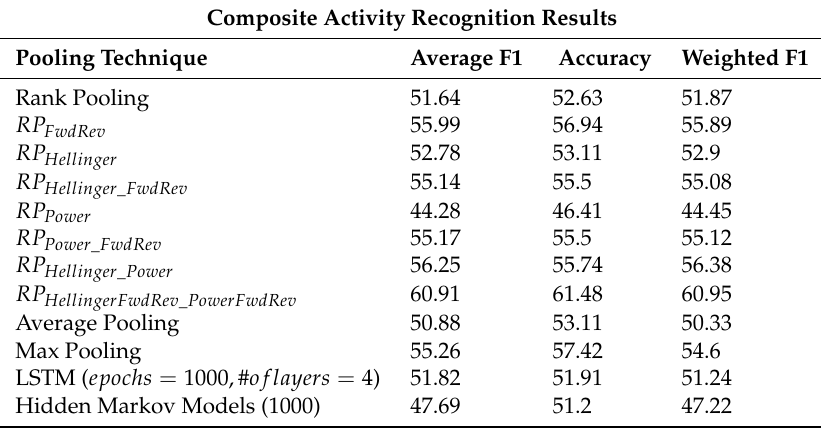
Table 3. Comparison of pooling techniques: hold-out setting.